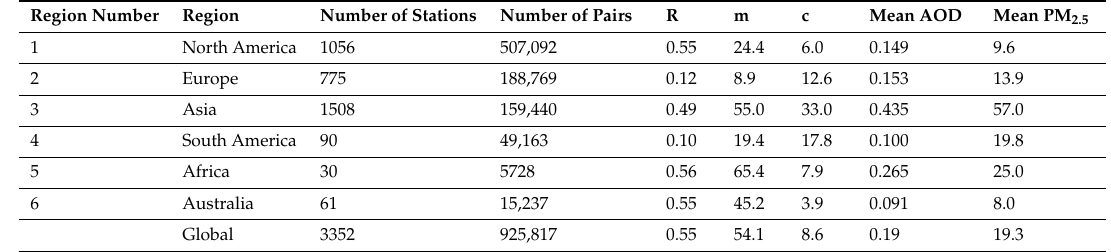
Figure1. ( a )Globaldistributionofaerosolopticaldepth(AOD)fromcombinedTerraandAquaModerate Resolution Imaging Spectroradiometer (MODIS) for 2019 and ( b ) number of surface particulate matter with aerodynamic diameters less than 2.5 µ m (PM 2.5 ) monitors grouped within each 1 × 1 degree box for 2019. Relevant statistics for the rectangular boxes are shown in Table 1. Table 1. Regional and global statistics of AOD–PM 2.5 pairs where R, m, and c are linear correlation coe ffi cient, slope, and intercept, respectively. The regions are outlined and numbered as various rectangular boxes in Figure